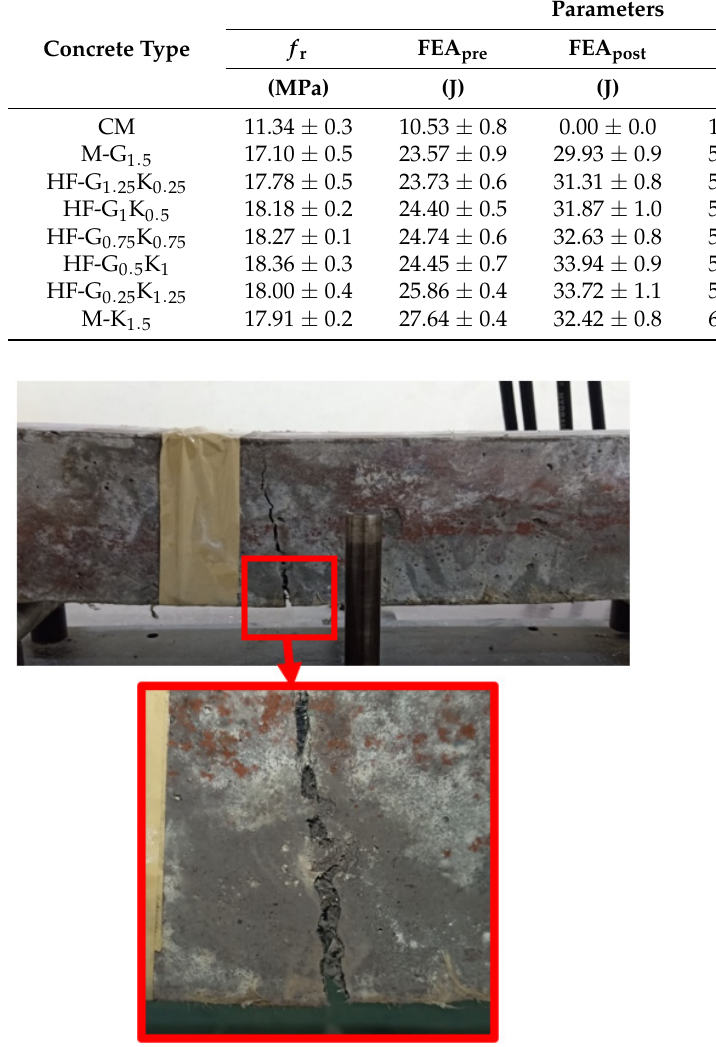
Figure 7. Bridging effects in HPFRC and HPHFRC specimens under flexural loading. Table 9. Properties of concrete specimens under flexural loading.